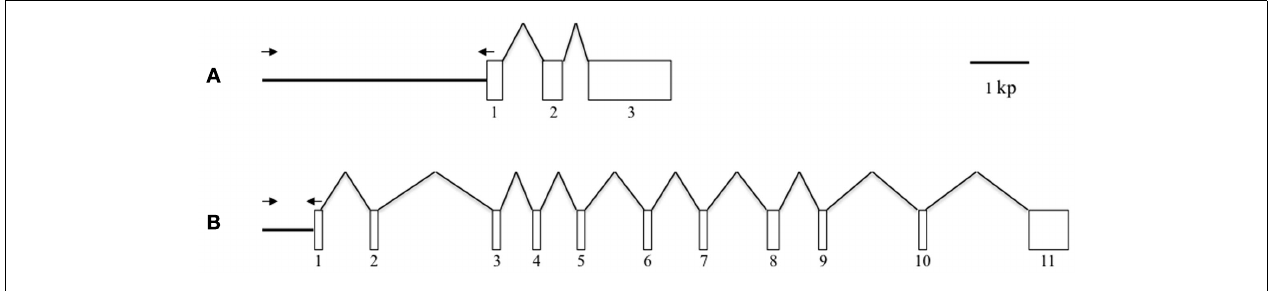
respectively. Arrows indicate the position and direction of primers used to amplify the upstream region of the genes in this study. Numbers denote the exon